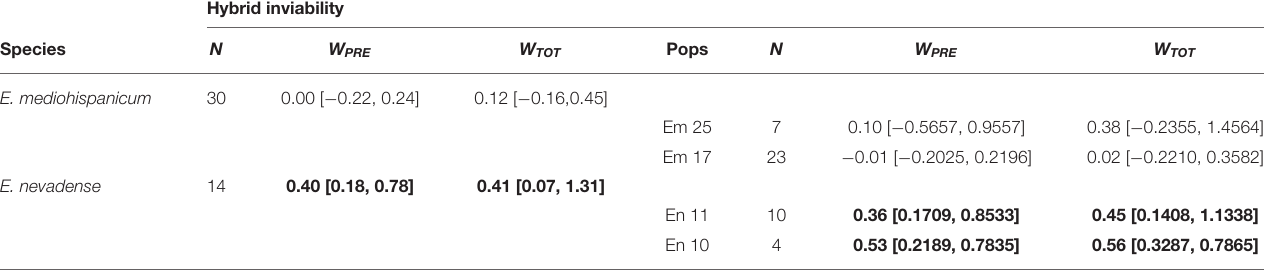
TABLE 6 | Reproductive barrier estimation between E. mediohispanicum and E. nevadense . Hybrid